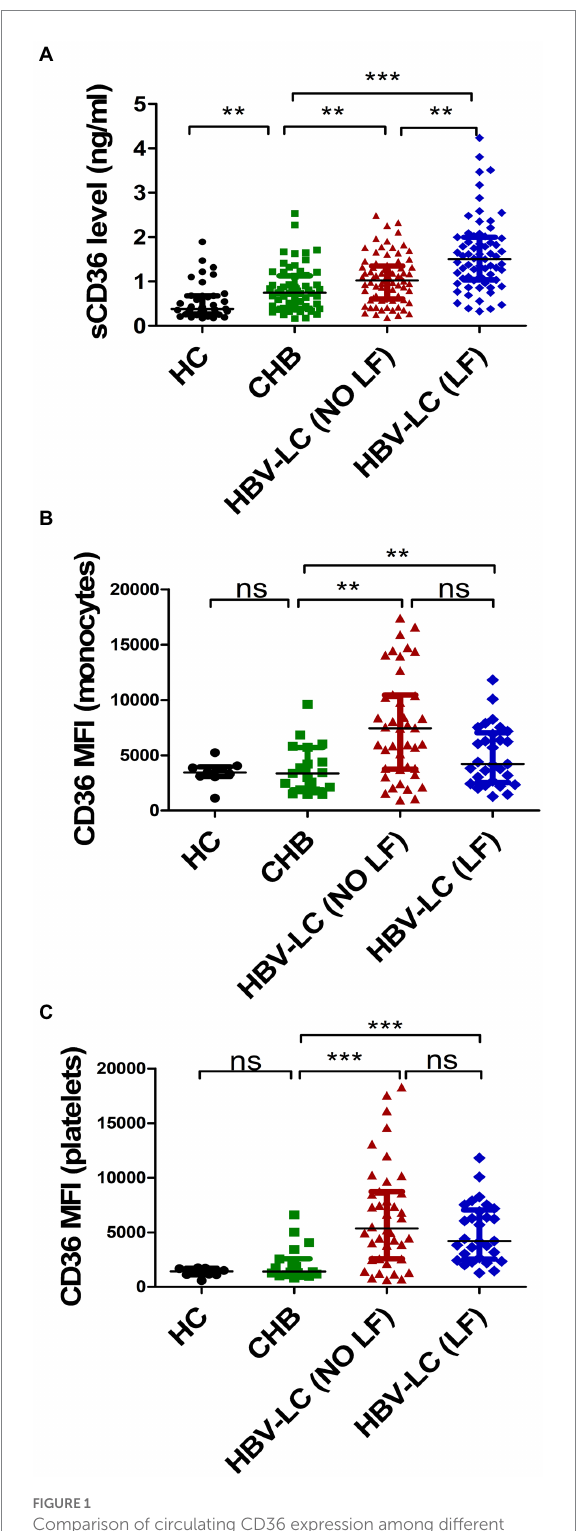
FIGURE 1 Comparison of circulating CD36 expression among different groups with HBV-related liver diseases. All subjects were divided into four groups at enrollment according to the diseases status, including healthy control (HC) group, chronic hepatitis B (CHB) group, HBV-related cirrhosis without liver failure (HBV-LC, NO LF) group, and HBV-related cirrhosis with liver failure (HBV-LC, LF) group. (A) Plasma sCD36 level in HC ( n = 38), CHB ( n = 61), HBV-LC